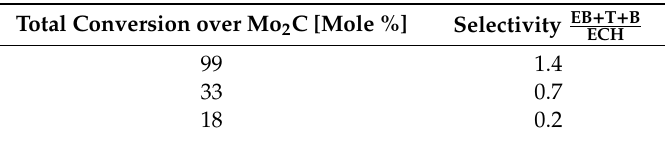
Figure 3 represents the distribution of the products (as mole %) of the HDN of indole over Mo 2 C vs. contact times ( t c Table 2. Selectivity between route #1 and #2 for Mo 2 C catalyst during indole HDN carried out at 613 K, 6 MPa of H 2 , H 2 /feed = 600, S = 50 ppm.